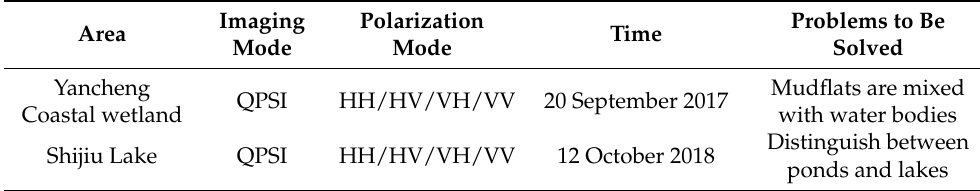
Figure 1. Research area: ( A ) Yancheng coastal wetland on the upper right; ( B ) Shijiu Lake on the lower right. Table 1. Data information and problems to be